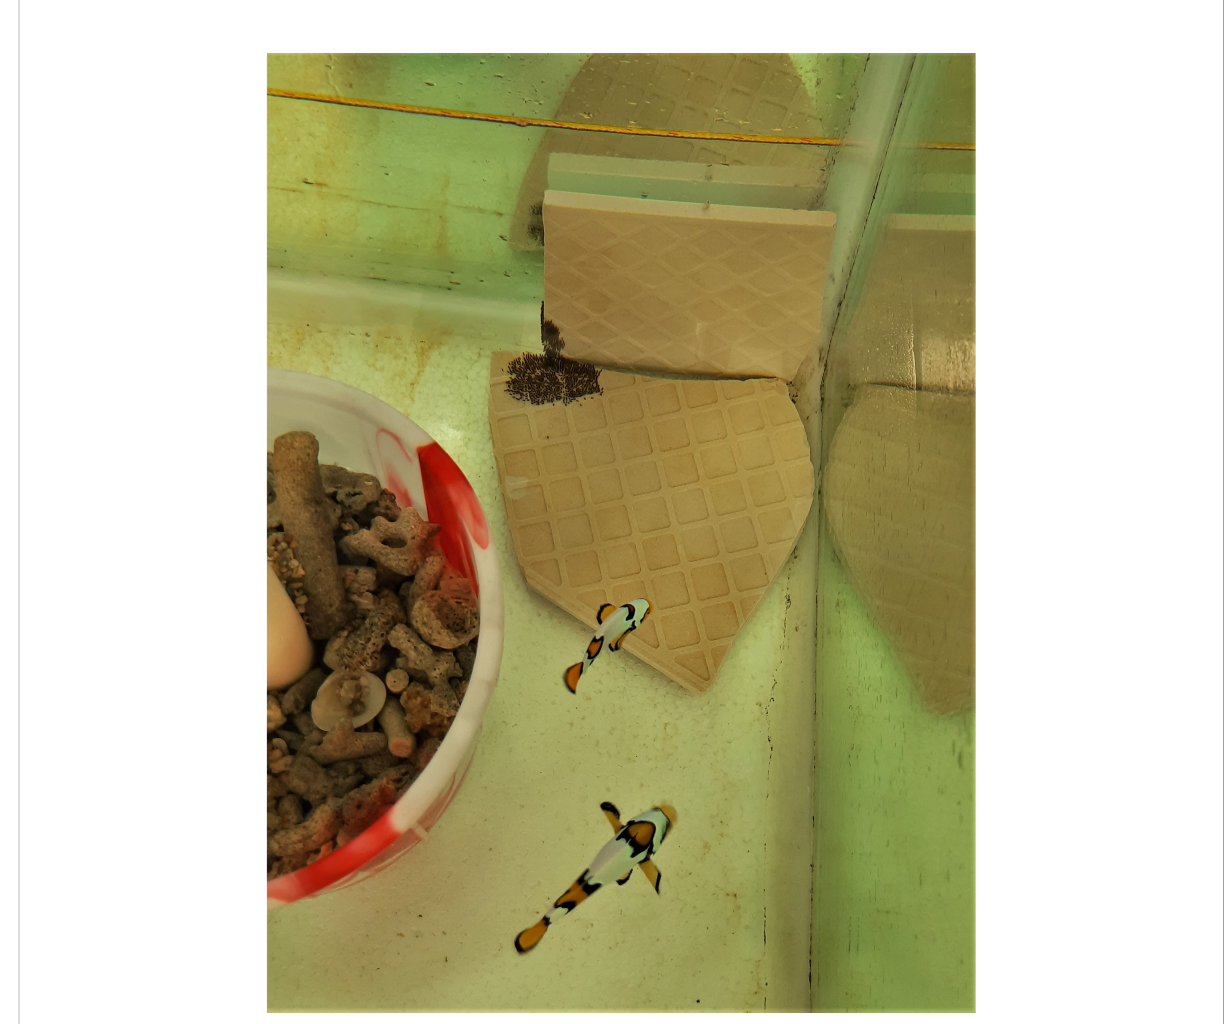
FIGURE 7 Designer clown fi sh brooders with eggs deposited on ceramic tiles (brown